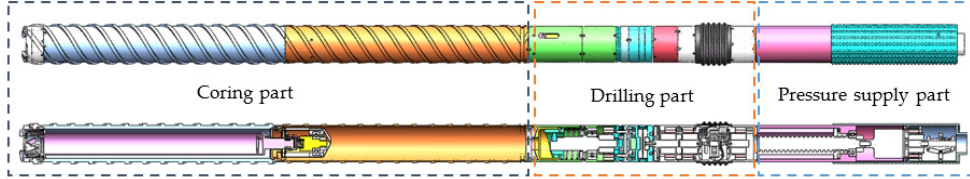
Figure 3. Design of the WSC robot.